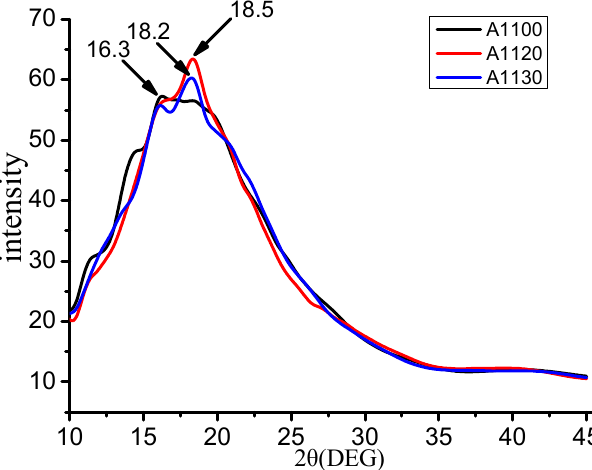
Figure 10. X-ray diagram of compound model of silane coupling agents with different chain length.